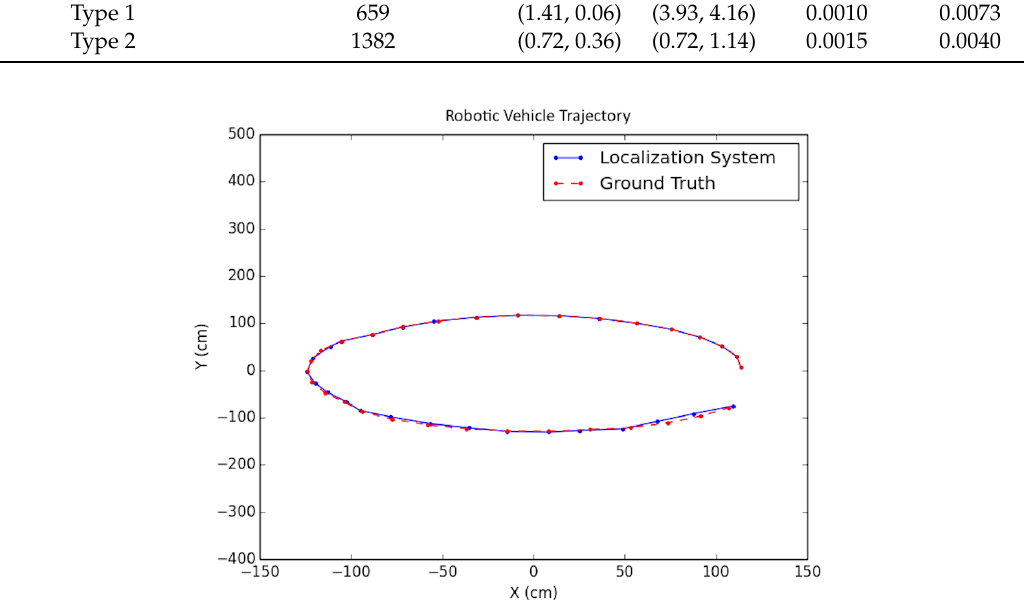
Figure 15. Synthetic test trajectory 1 (different from that in [2]).